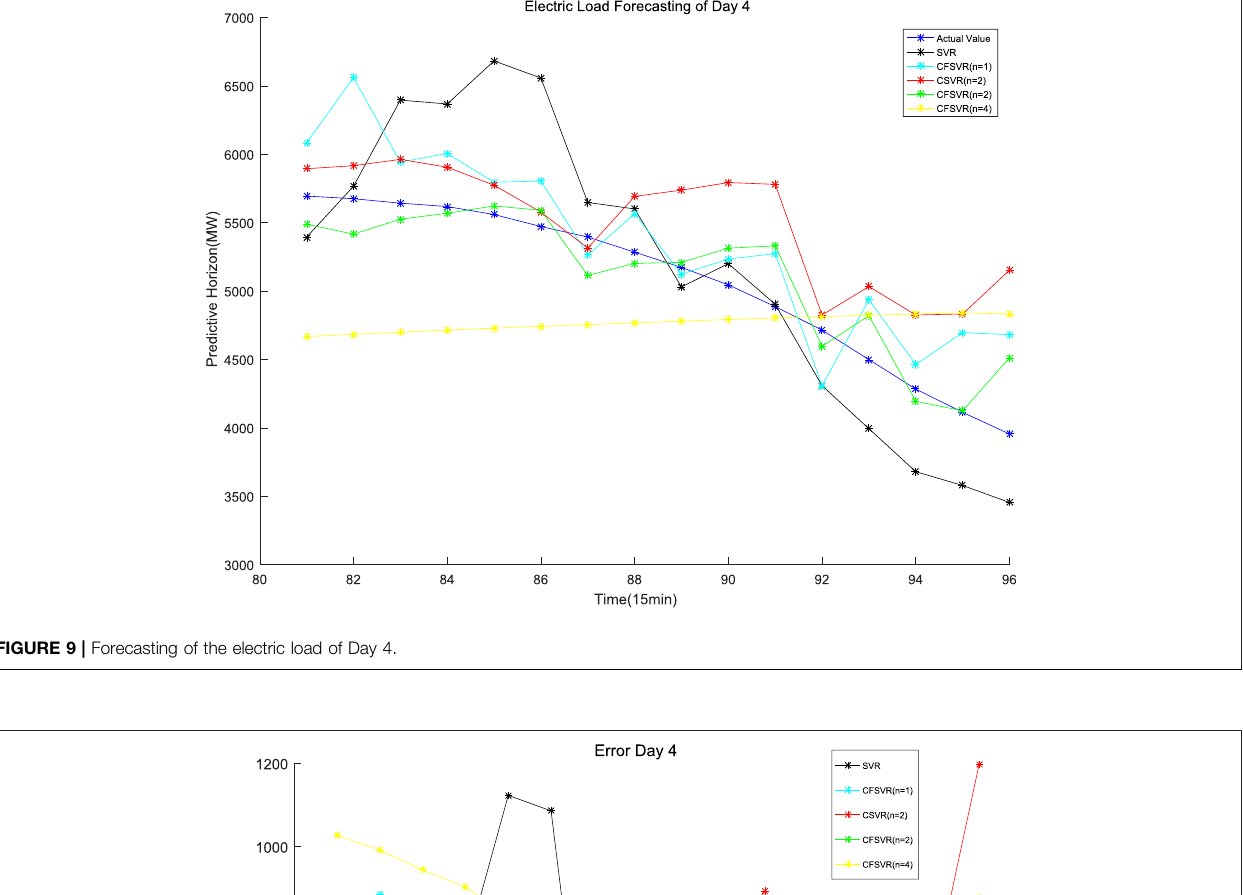
FIGURE 9 | Forecasting of the electric load of Day 4.